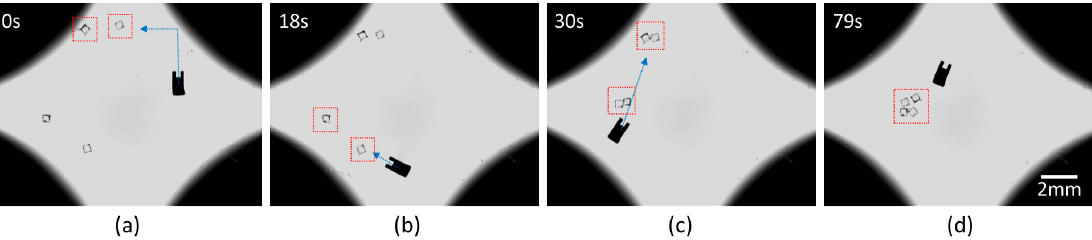
Figure 9. Snapshots of micromodules’ assembly by magnetic micromachine. ( a ) Assembly of the first subgroup; ( b ) assembly of the second subgroup; ( c ) assembly of the larger group; ( d ) images of the final entirety.